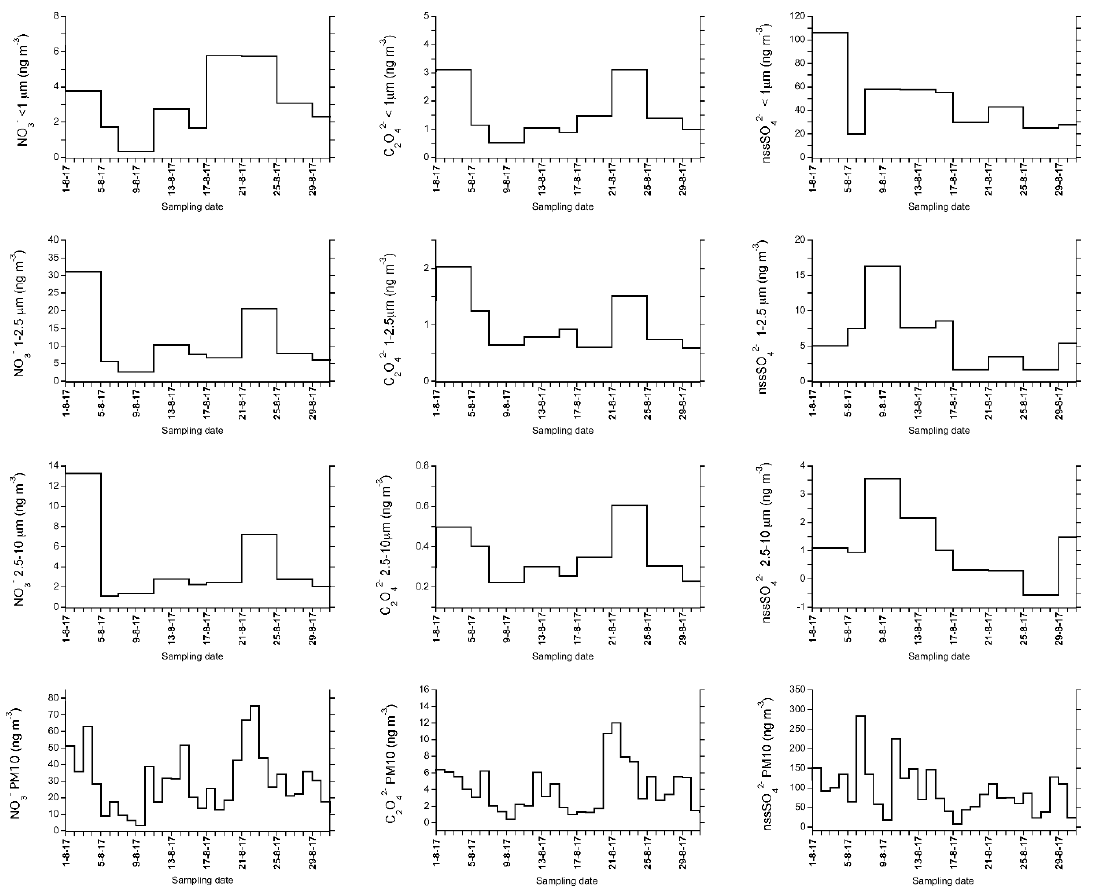
Figure 4. Concentration vs. time profile of nitrate, oxalate, and non-sea salt sulphate in size-segregated and bulk PM 10 aerosol at Gruvebadet in the period 28 July 2017–24 September 2017.